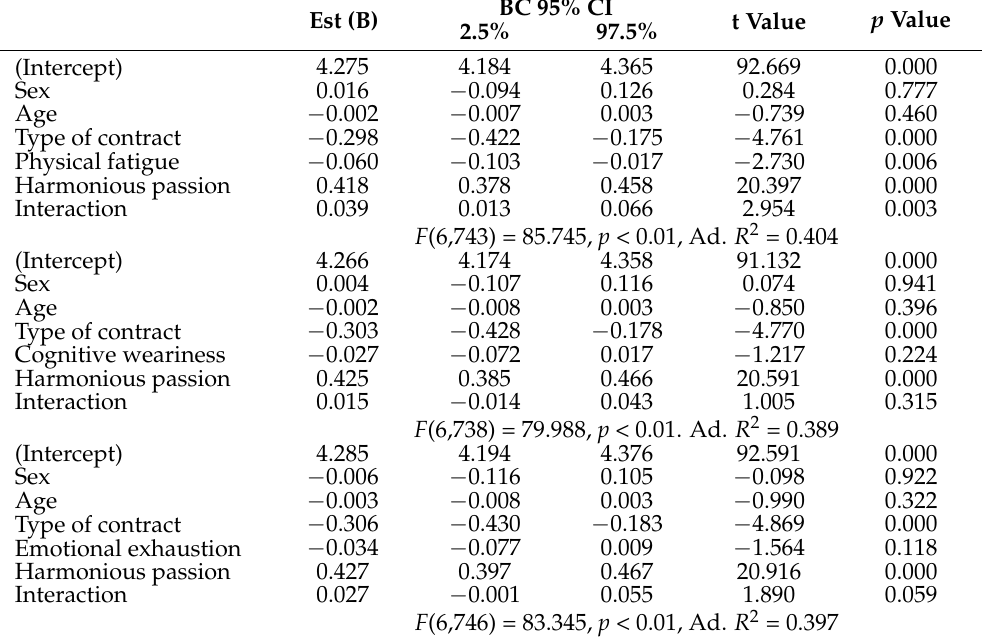
Table 2. Analysis of the moderating role of harmonious passion in the relationship between burnout and intrinsic job satisfaction ( n =